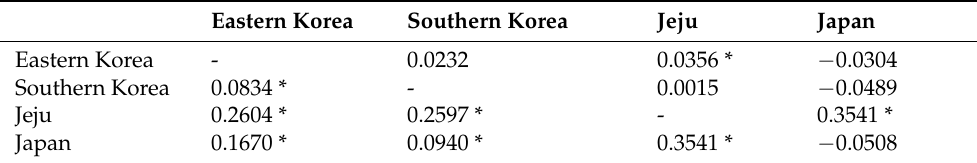
Table 3. Pairwise F ST values for P. lanceolata (lower left) and P. elliptica (upper right). Significant p -values indicated by * p <